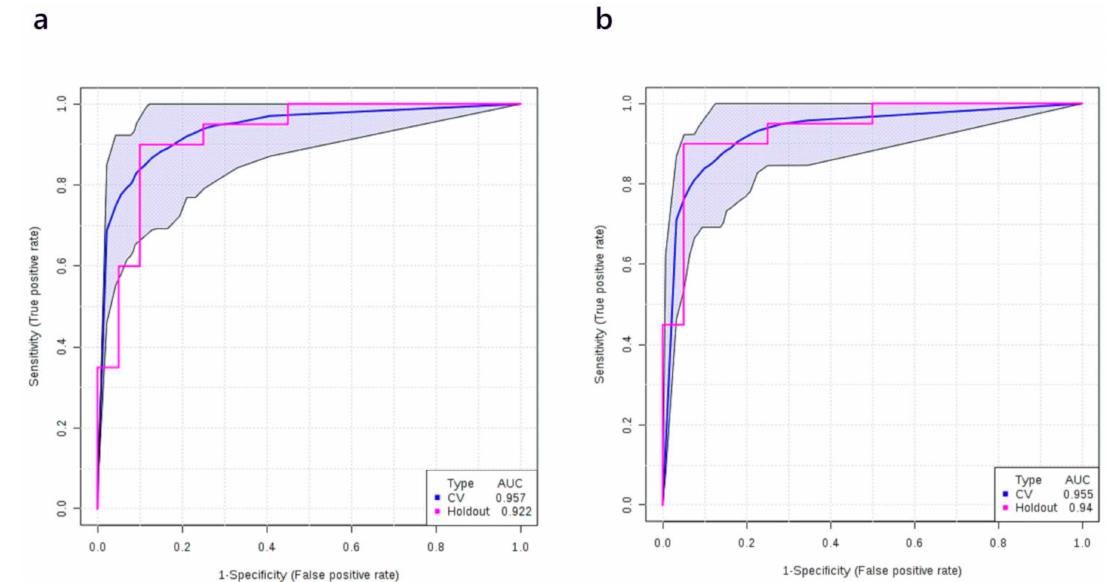
Figure 4. ROC curve generated by the logistic regression models for stage II NSCLC patients. ( a ) ROC